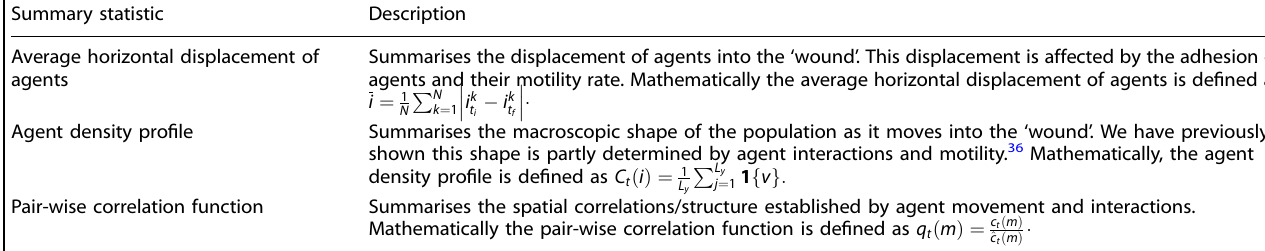
Table 1. The summary statistics we implement and the properties of the agent population they summarise Summary statistic